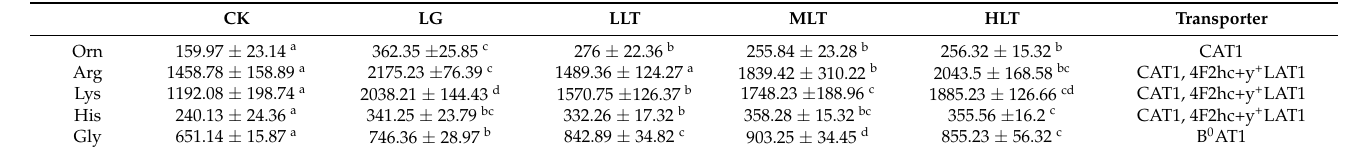
Table 2. Effects of L-theanine on amino acid content in mouse duodenum. CK (control),